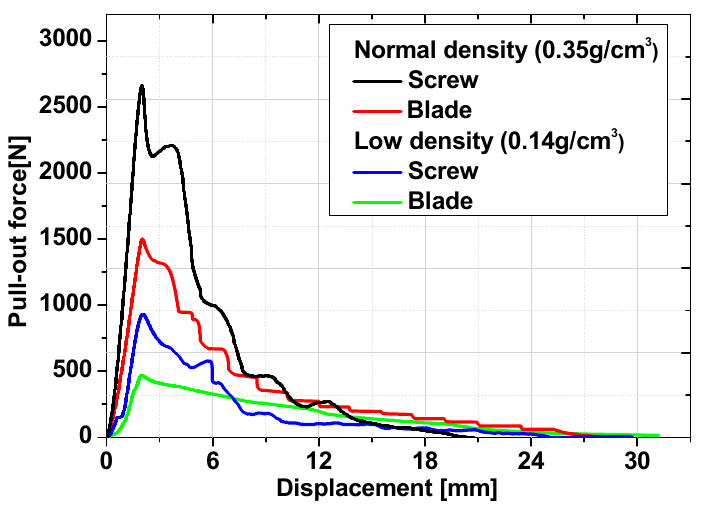
Figure 5. Experimental results of pull-out test with screw and helical blade with respect to different foam densities.